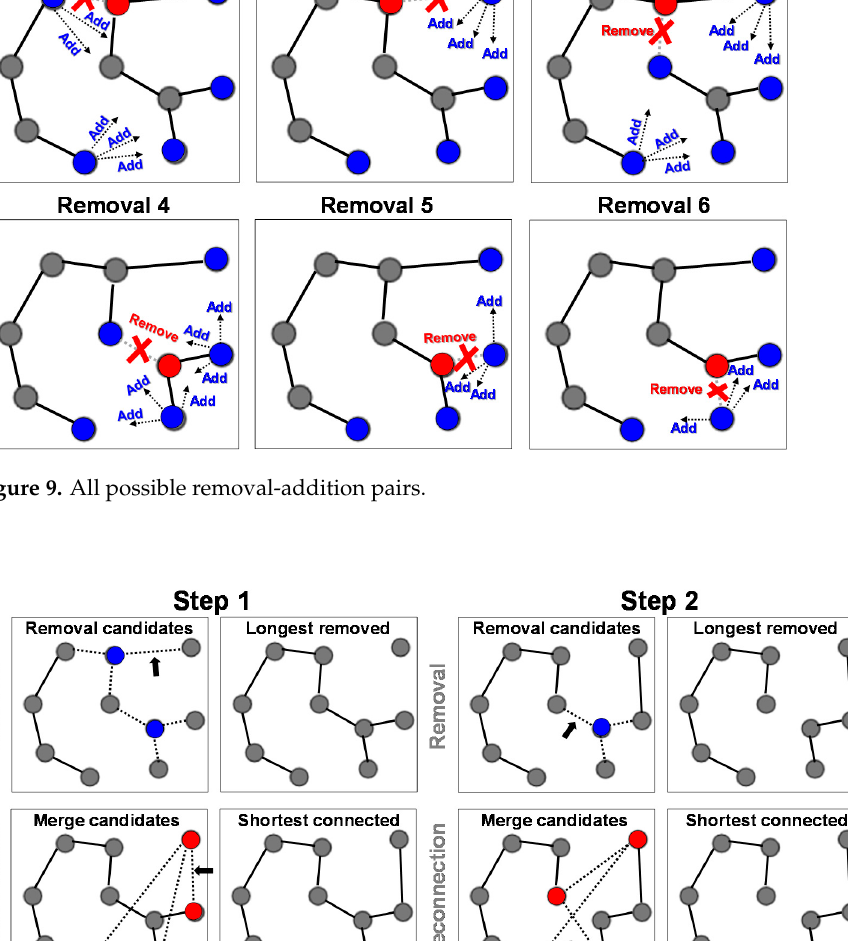
Figure 12. Example of the Greedy and All-pairs variants. Greedy removal leads to the same sub- optimal result as TSP-Kruskal while allowing to remove shorter link, the optimal solution can be easily reached. Figure 13. Parallel chains where only MST-to-TSP (All-pairs variant) finds the optimal path. 3.3. Randomized Variant The algorithm can be further improved by repeating it several times. This improve- ment is inspired by [34] where k-means clustering algorithm was improved significantly by repeating it 100 times. The only requirement is that the creation of the initial solution includes randomness so that it produces different results every time. In our randomized variant, the final solution is the best result out of the 100 trials. The idea was also applied for the Kruskal-TSP and called Randomized Kruskal-TSP [8]. There are several ways how to randomize the algorithm. We adopt the method from [8] and randomize the creation of MST. When selecting the next link for the merge, we randomly choose one out of the three shortest links. This results in sub-optimal choices. However, as we have a complete graph, it usually has several virtually as good choices.